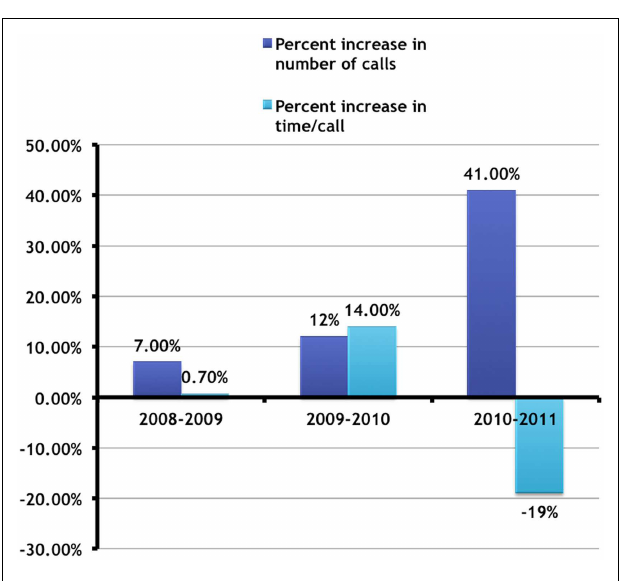
FIGURE 6 | Change in number vs. time per call (July–December). This combines the data from Figures 4 and 5 and shows these changes as a percentage change from the previous years during the same time period. It can be seen that there were marked changes from 2010 to 2011 in that while the number of calls increased significantly, the time taken per call decreased significantly.This did not happen in previous years, and